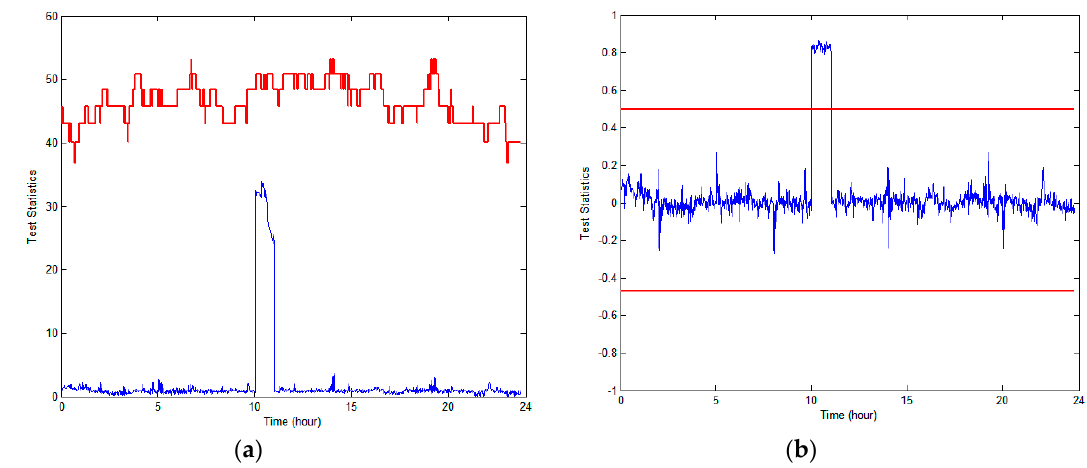
Figure 9. Performance comparison of anomaly detection schemes when a +100-m bias was injected